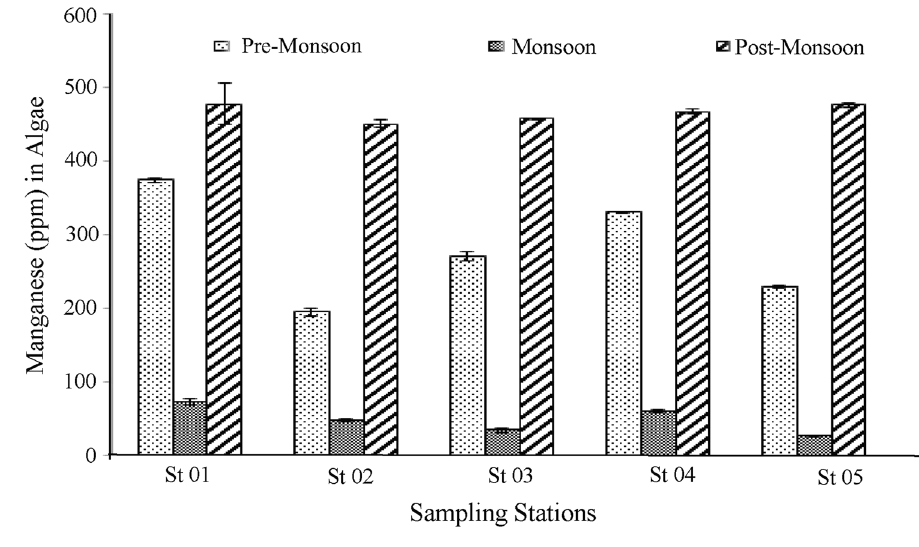
Fig. 12 Algal copper concentra- tion (± SD) variation at different seasons in different stations of Sundarban mangrove